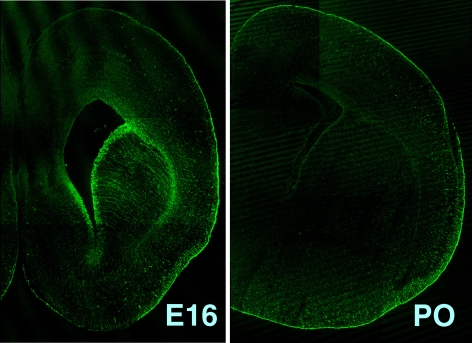
Expression of Fabp7 protein in mouse brains at embryonic day 16 (left) and postnatal day 0 (right). At both stages, Fabp7 is strongly expressed in the ventricular zone and radial glia, where neurogenesis is prominent.